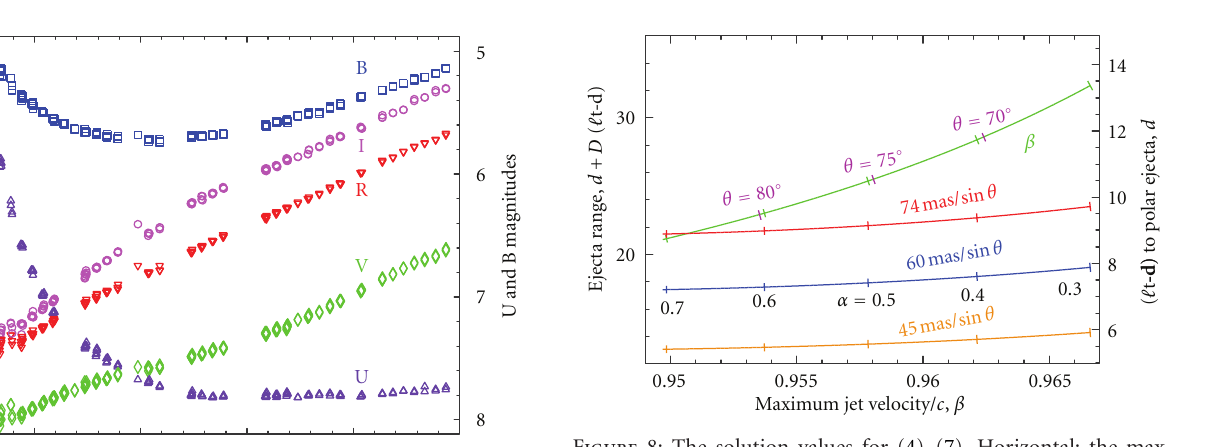
Figure 8: The solution values for (4)–(7). Horizontal: the max- imum jet velocity, β . Left vertical: the maximum range of the polar ejecta. Right vertical axis: the distance from the pulsar to the beginning of the polar ejecta. The line with the steepest slope converts β (bottom) to D + d (left) or d (right), and three values for θ are marked. The three other lines with moderate slopes constrain the minimum of D + d (right end of 74 mas curve) and the maximum of d (left end of the 45mas curve and also read on the left vertical axis) from o ff set measurements of the Mystery Spot, which is assumed to be a jet-driven plume within the polar